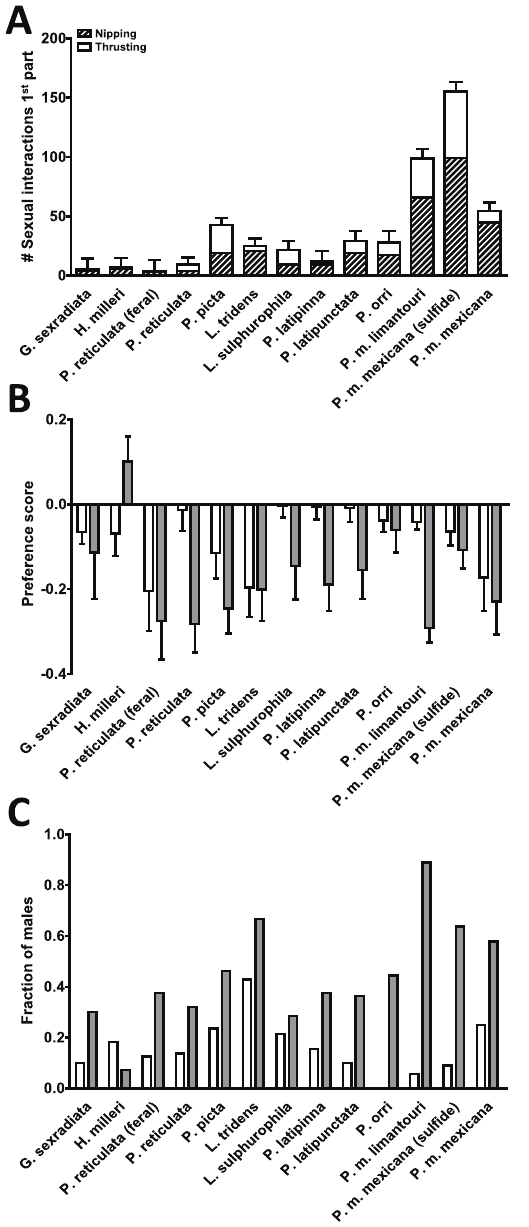
Figure 2. ( a ) Mean (± SE) numbers of male sexual behaviors during the 10 min observation period. ( b ) Changes in individual focal males’ mate choice behavior in the presence of an audience male. Depicted are mean (± SE) preference scores (see main text), whereby negative values indicate that male preferences decreased in strength. ( c ) Proportion of males that first interacted with the opposite female when released from the acclimation cylinder in the second part of the tests. Open bars in ( b ) and ( c ) represent the control treatment (no audience) while gray bars represent the audience